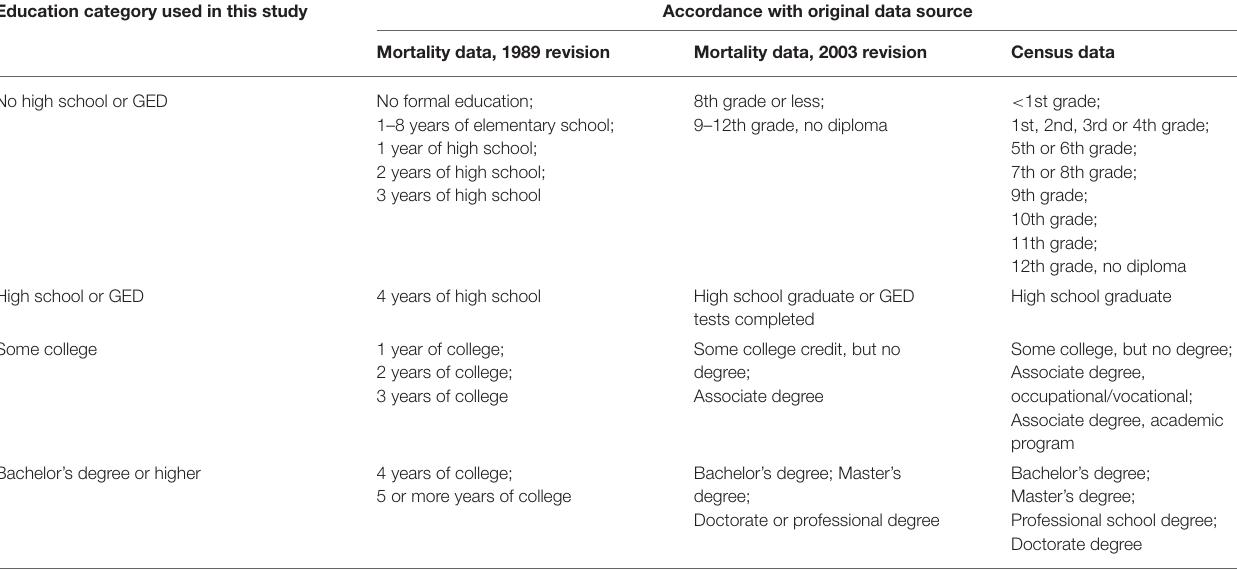
TABLE 1 | Definitions of education categories and accordance with original data